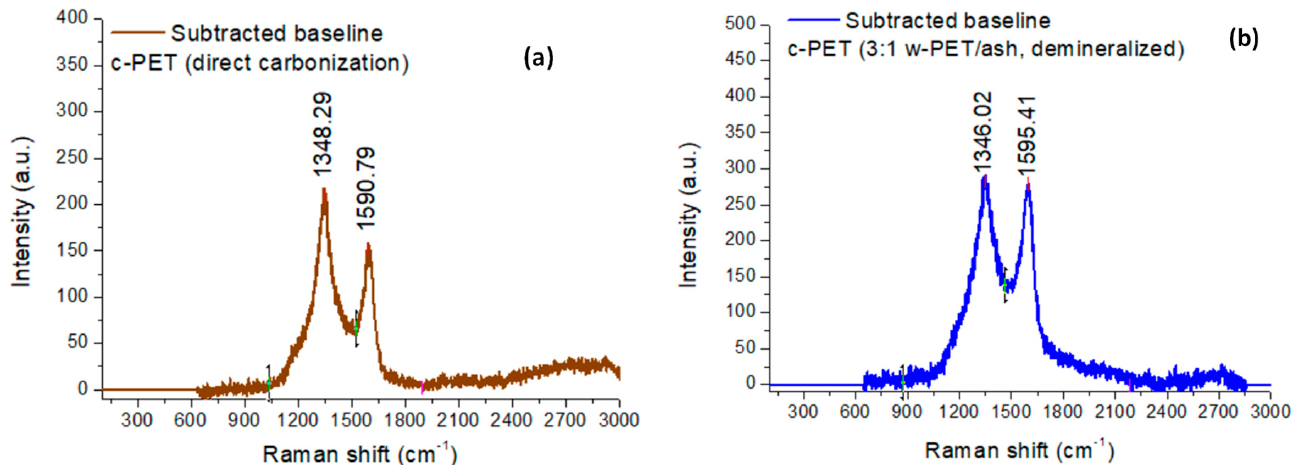
Figure 6. Raman spectra measured on c-PET powder samples from 100–3000 cm ‒ 1 at an excitation wavelength of 532 nm: ( a ) c-PET from direct carbonization of w-PET and ( b ) c-PET from co-carbonization of the 3:1 w-PET/d-coal ash composite. The selected peaks presented were baseline corrected/subtracted from the original spectra in Figure S3.